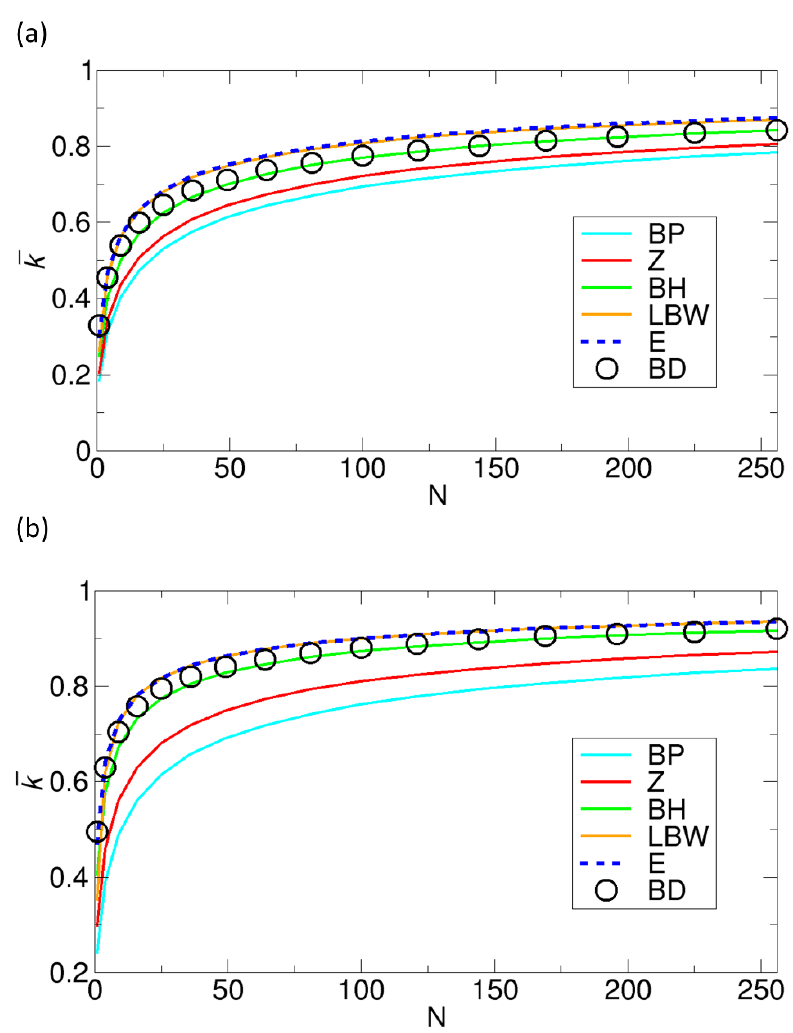
Figure 8. Comparison of the normalized rate constants k as functions of the number of patches N , obtained from various theories with the rate constant from BD simulations with random patch arrangements by Lu [29] under fixed values of σ of ( a ) 0.125 and ( b ) 0.25. The normalized rate constants for the Berg-Purcell (BP), the Zwanzig (Z), the boundary homogenization (BH), the Lindsay-Bernoff-Ward (LBW), and our (E) theory are calculated from Equations (1), (2), (3), (4), and (6), respectively.